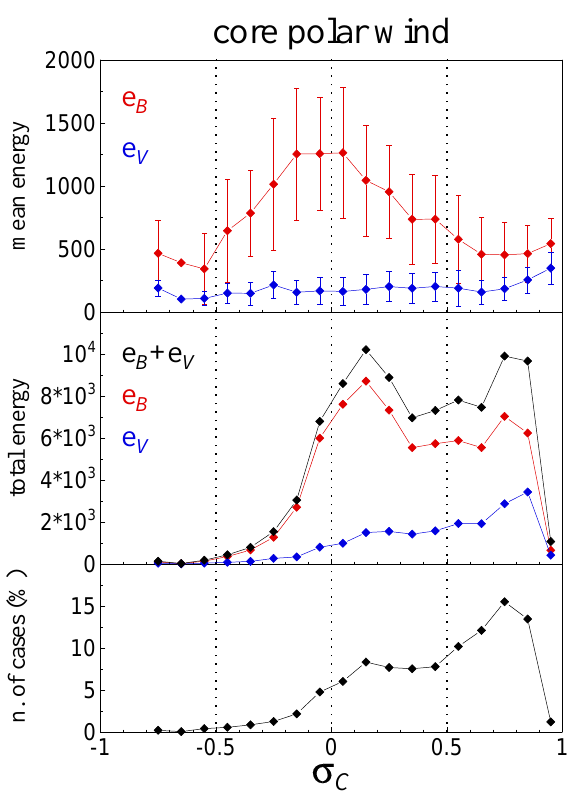
Fig. 2. σ C - e B (top) and σ C - e V (bottom) scatter plots for core (left) and boundary (right) polar wind intervals. Fig. 3. Energy distributions versus cross-helicity for core polar wind. The top and middle panels give mean and total values of the magnetic (red) and kinetic (blue) energies (in km 2 /s 2 ) for 0.1-bin of σ C , respectively. In the top panel error bars are standard deviations. In the middle panel the black line refers to the sum of magnetic and kinetic energies. The bottom panel gives the number of cases (in per cent) for each σ C bin.